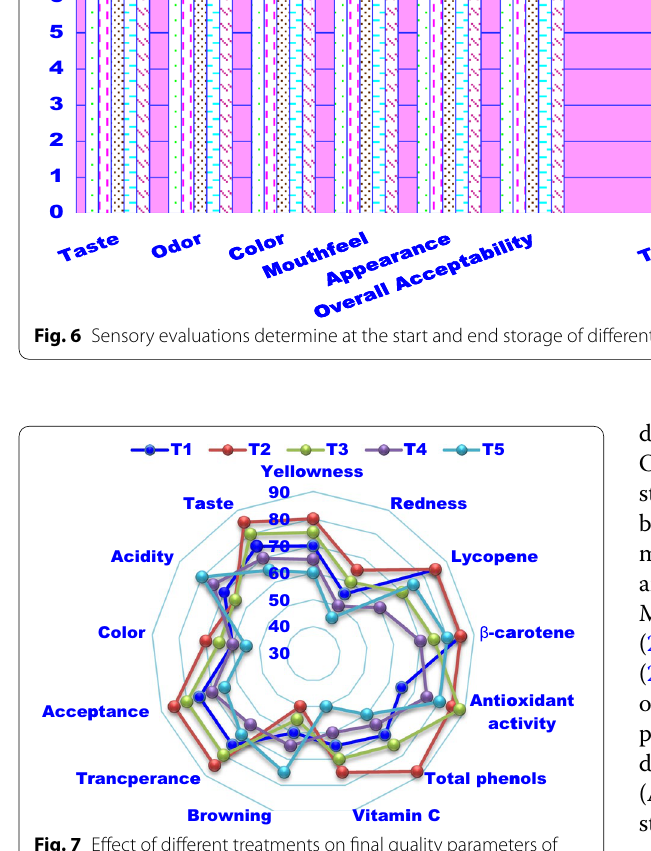
Fig. 7 Effect of different treatments on final quality parameters of syrups after storage